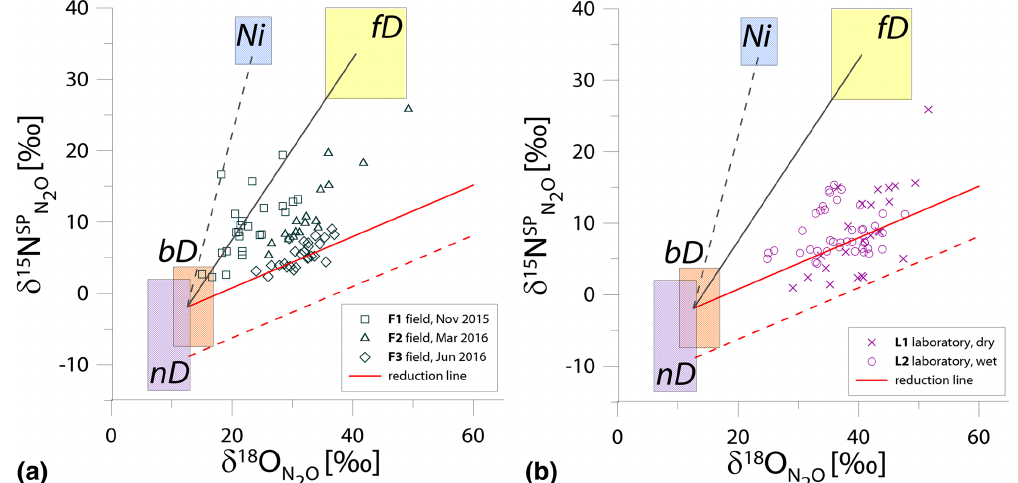
Figure 1. N 2 O isotope data of field ( a , green points) and laboratory studies ( b , purple points) in SP / O MAP presented with literature endmember values and theoretical mixing (grey line) and reduction (red line) lines. The solid lines (bD-fD mixing and mean reduction line) are main assumptions used in the calculation procedures for SP / O MAP. The dashed grey line shows the alternative bD-Ni mixing line (calculations with this alternative scenario are also presented in Table S1 in the Supplement). The dashed red line shows the minimum reduction line – for the case of minimal delta values of the bD endmember. δ 18 O values of mixing endmember bD, nD, and fD are presented in relation to the mean measured ambient water of − 6.4‰ (hence present the expected δ 18 O N these study